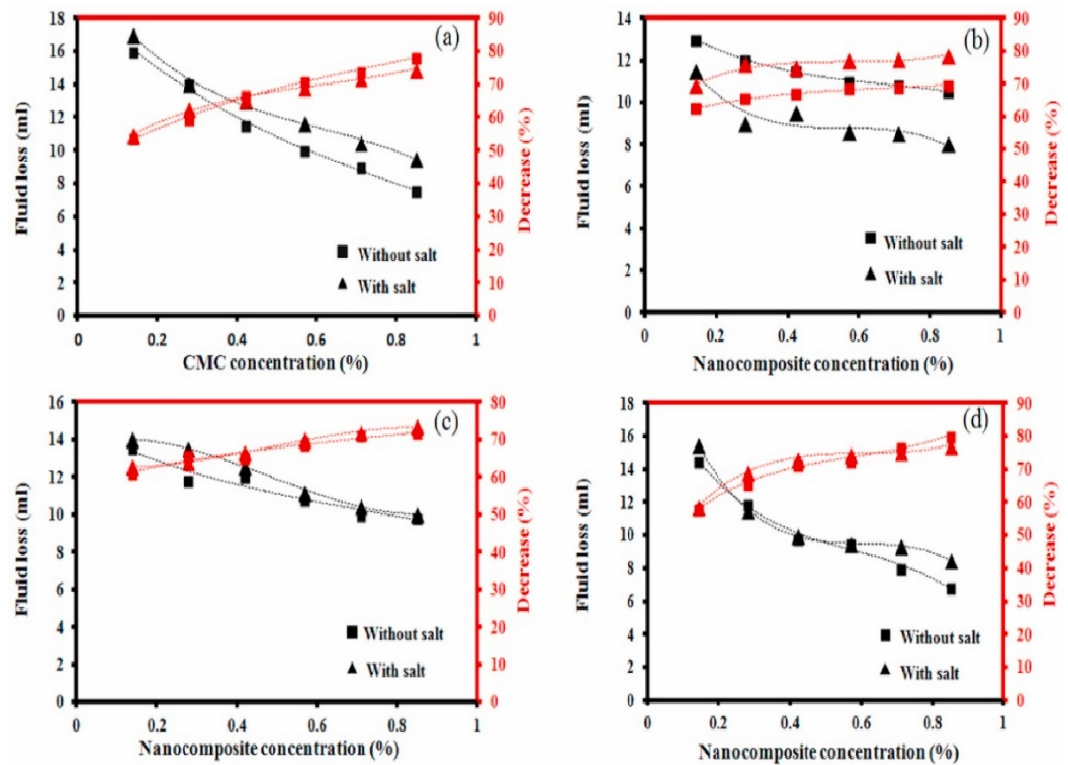
Figure 10. Fluid loss acquired using ( a ) CMC, ( b ) 1:6, ( c ) 1:4, and ( d ) 1:3 Fe 3 O 4 -CMC nanocomposite ratios. Higher ratios of nanocomposite show improved fluid loss volume compared to CMC [107].